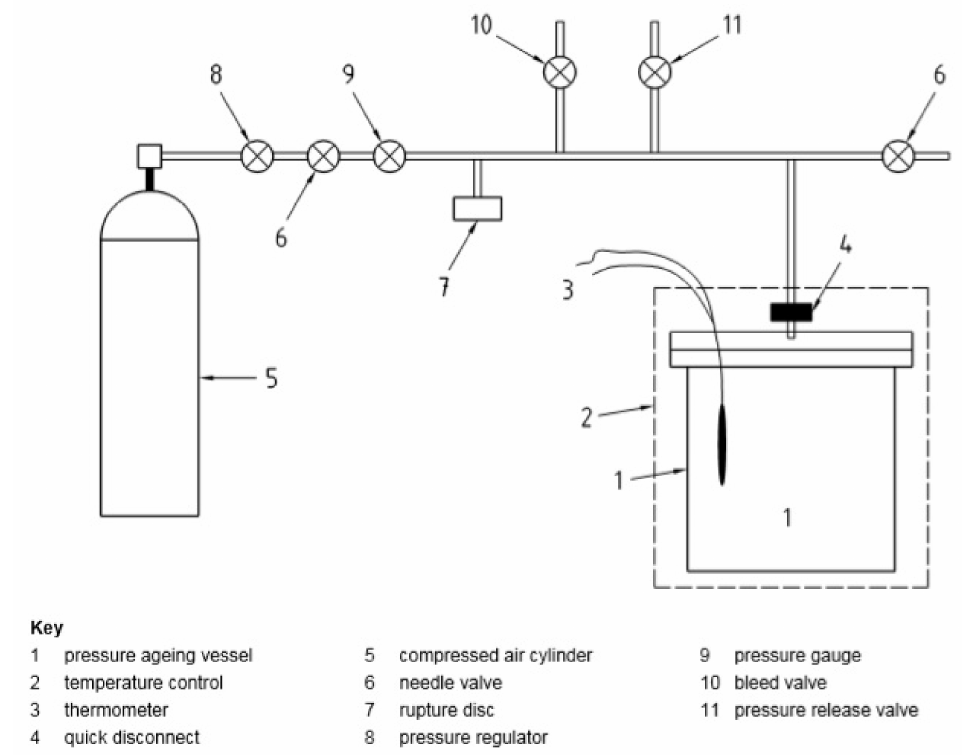
Figure 7. Diagram of the PAV aging setup [EN